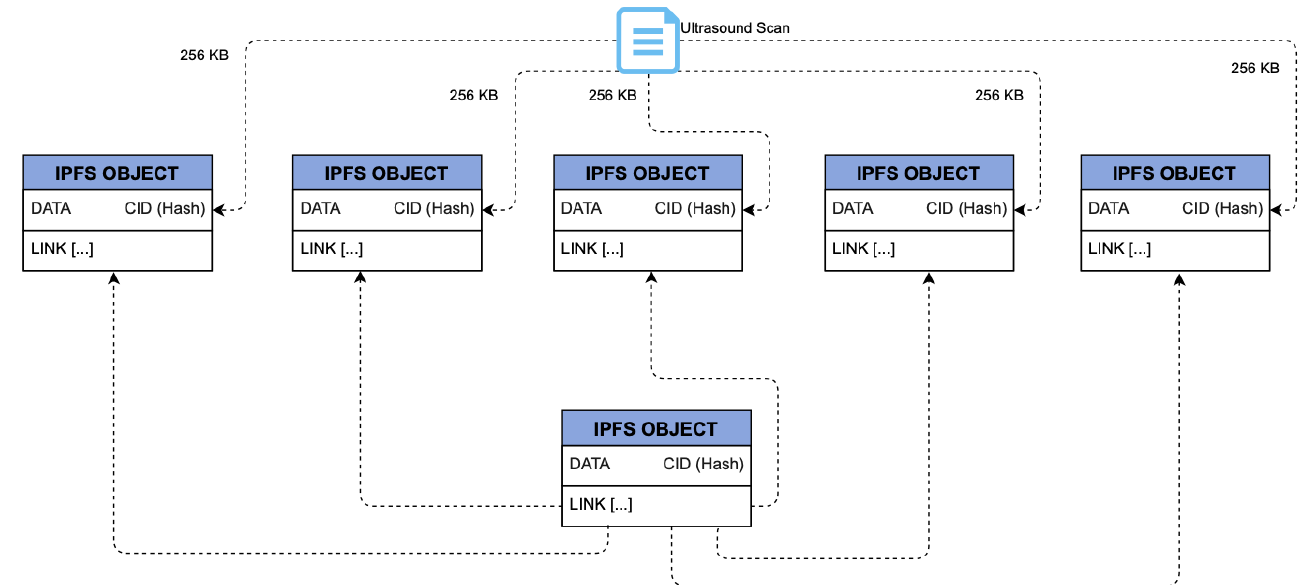
Figure 20. IPFS redundancy for EHRChain.